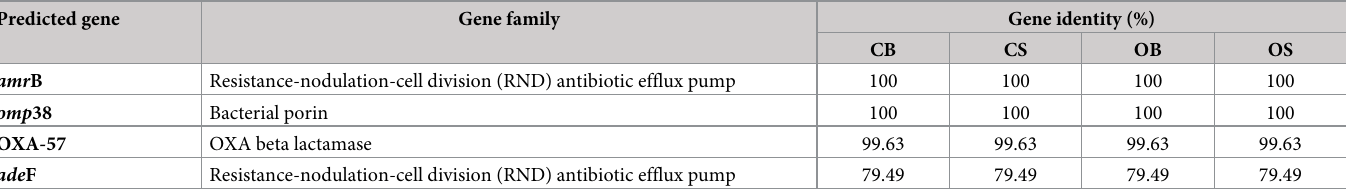
Table 4. Predicted antimicrobial resistance genes in Burkholderia pseudomallei strains. Predicted gene